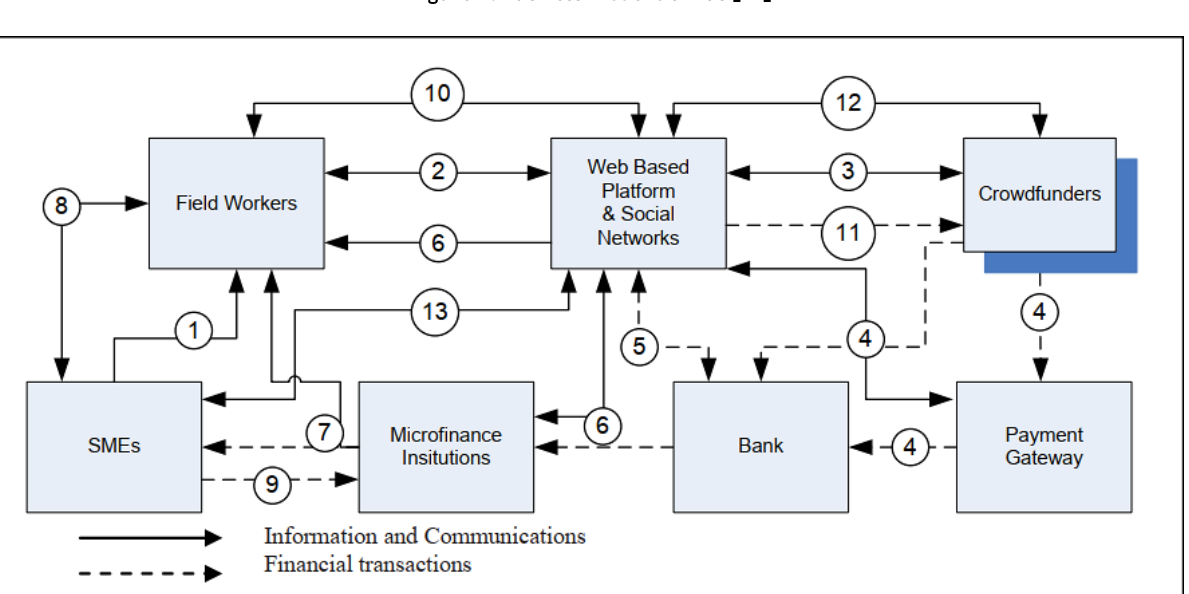
Figure 3. Modified typology of Hamer model